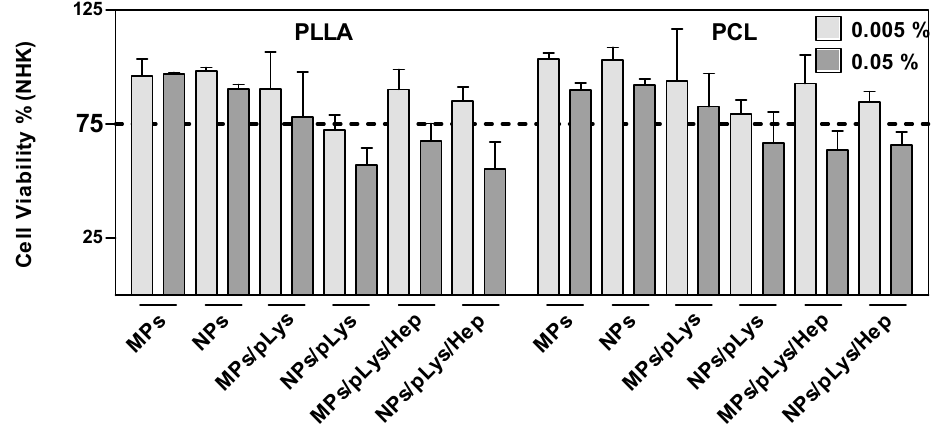
Figure 5. Effect of polyester particles on cell viability. NHK were exposed to the indicated concentrations for 24 h. A declined formazan formation <75% after MTT exposure indicates cytotoxicity. Data are presented as mean ± SD, n = 3.